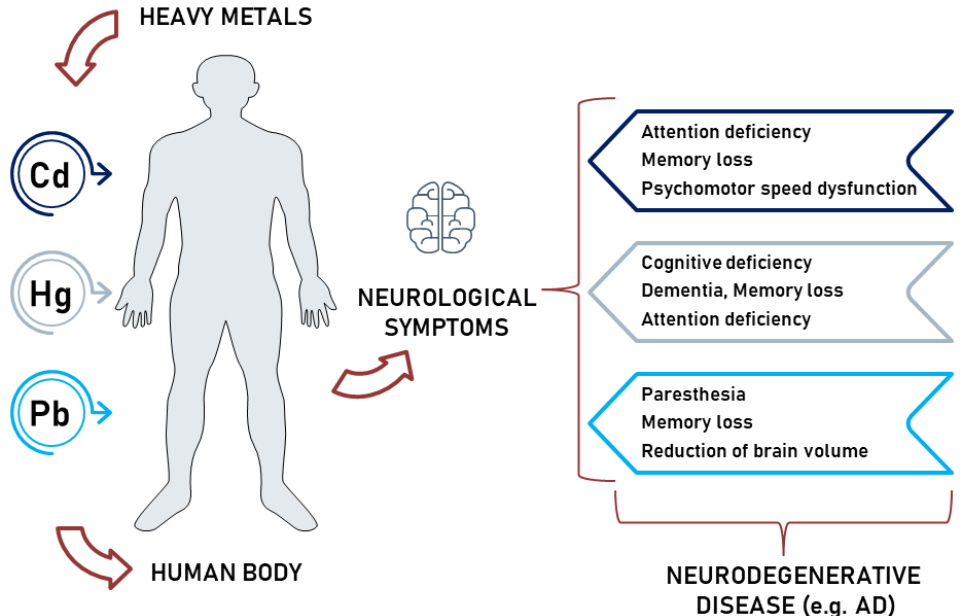
Figure 3. Exposure to highly toxic metals (Cd, Hg, Pb) induces neurological deficiency in the human body (data modified from Lee et al.